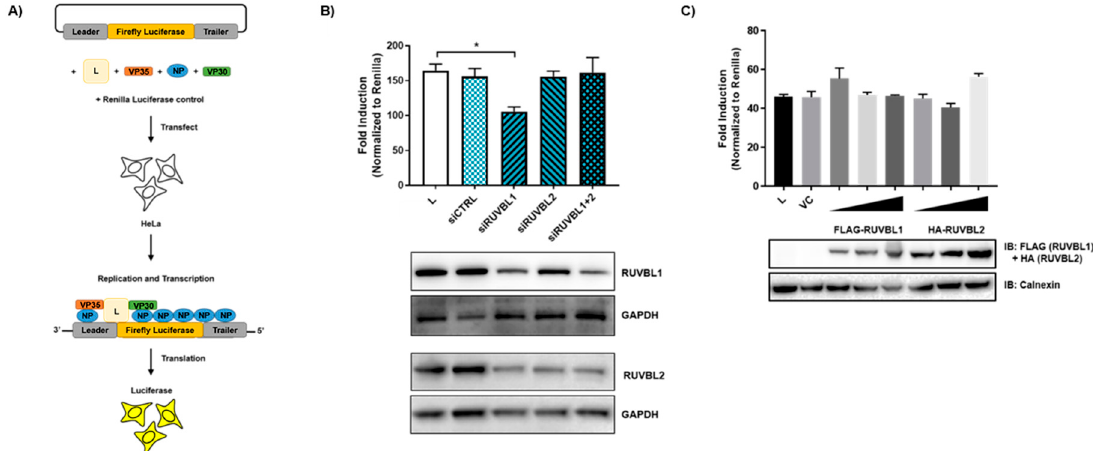
Figure 4. RUVBL1 / 2 do not e ff ect EBOV minigenome activity. ( A ) Schematic diagram of the Figure 4. RUVBL1/2 do not effect EBOV minigenome activity. ( A ) Schematic diagram of the EBOV minigenome system. The EBOV minigenome system consists of six plasmids: Four support plasmids encode replication complex components NP, L, VP35, and VP30. The EBOV minigenome plasmid